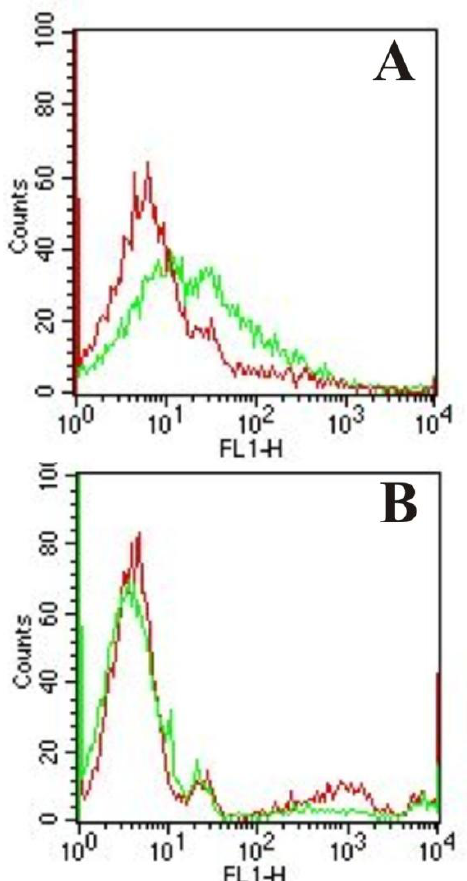
FIGURE 4. Uptake of vesicular components by neutrophils is increased upon inhibition of actin polymerization. To inhibit actin filament polymerization, neutrophils were suspended in PBSCM, 7.5 mM glucose with (green line) or without (red line) 5 µM cytochalasin D, and incubated for 1 h at 37°C. Cells were pelleted, resuspended, and incubated in autologous plasma, buffer, and FITC-labeled V vesicles (A) or opsonized, FITC- sto labeled zymosan (B) as described in the Materials and Methods section. Histograms of the distribution of fluorescent label in the cell population (FL-1 channel) reveal an cytochalasin D– dependent increase in the uptake of vesicular components (A) and an inhibition of zymosan phagocytosis